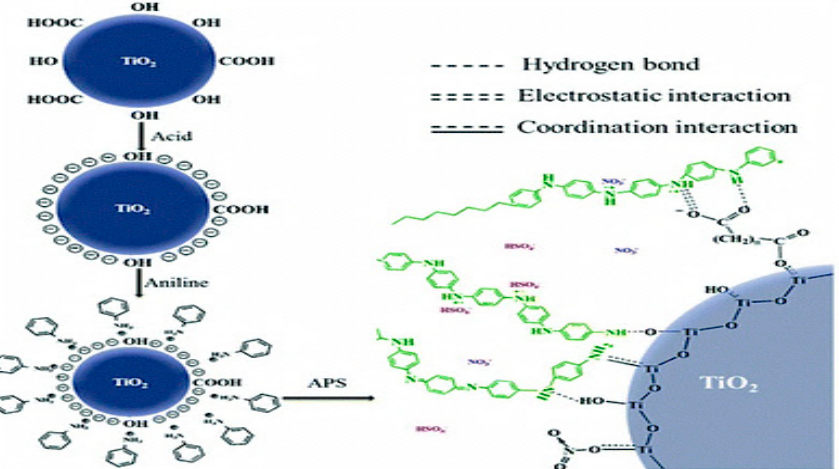
Figure 9. Schematic representation of the adsorption mechanisms by polyaniline/TiO 2 nanocomposite (taken from [89]).